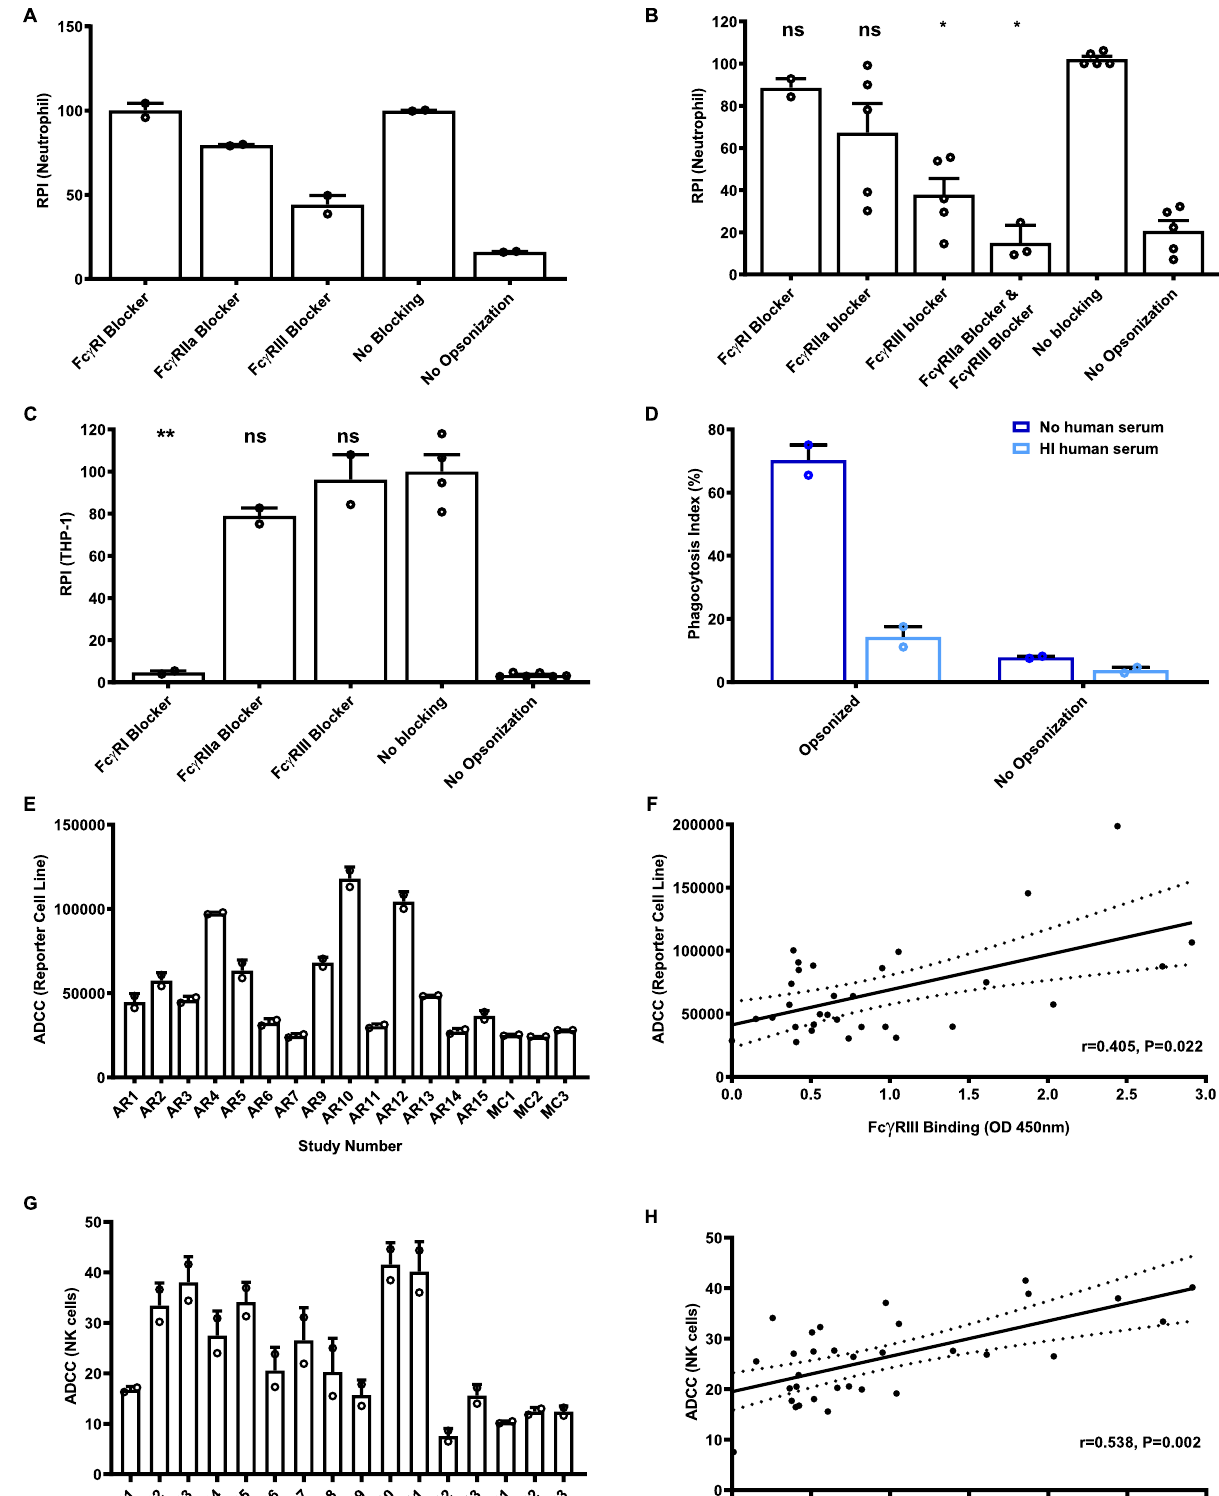
promote engagement of Fc γ RIIa and Fc γ RIII. Human antibodies bound each CSP region with suf fi cient density to promote binding of Fc γ RIIa and Fc γ RIII (Fig. 4B). As the total level of IgG binding varied among different CSP constructs (Supplementary Fig. 5), we standardised Fc γ RIIa and Fc γ RIII binding relative to